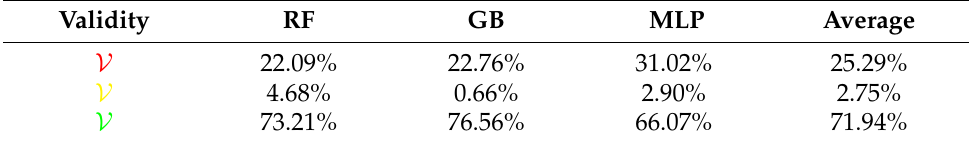
Table 10. Rate of validity of RHOASo vs. HPO across all D i (% with MCC and time